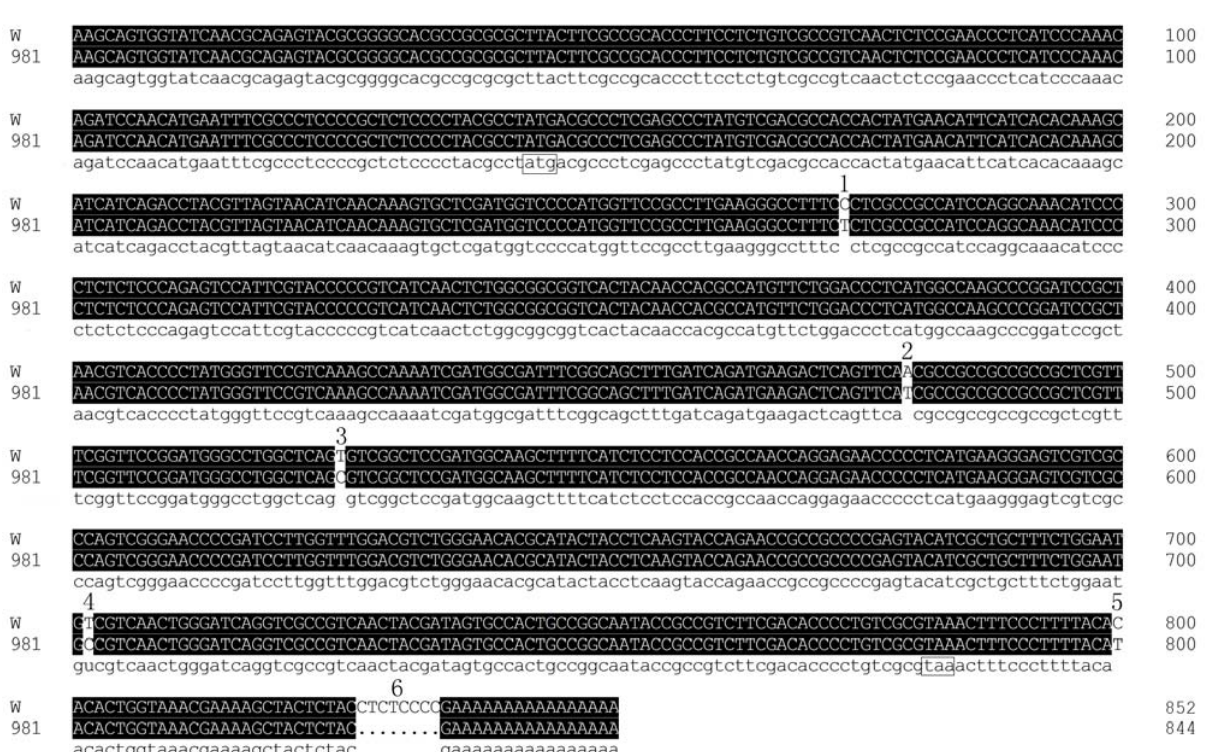
Figure 1. Comparison of cDNA sequences between W-SOD and 981-SOD. Start codon ATG and stop codon TAA are marked with boxes; the six differences are marked with Arabic